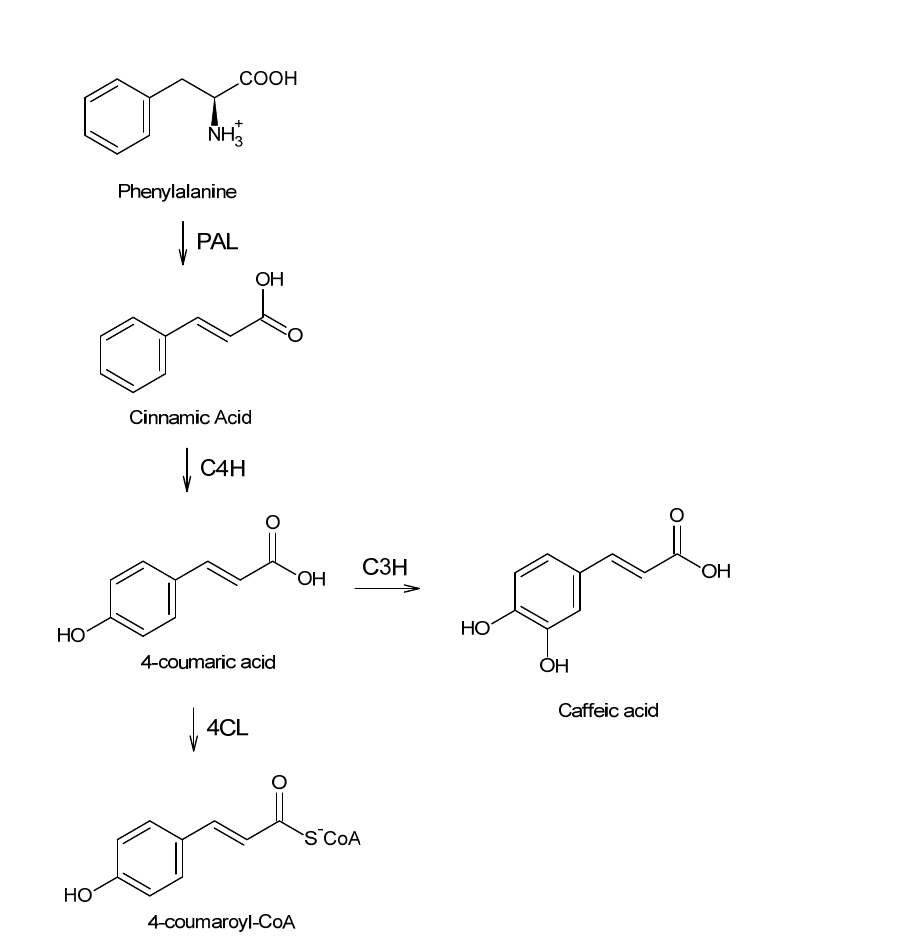
Figure 2. Phenylpropanoid pathway [58].